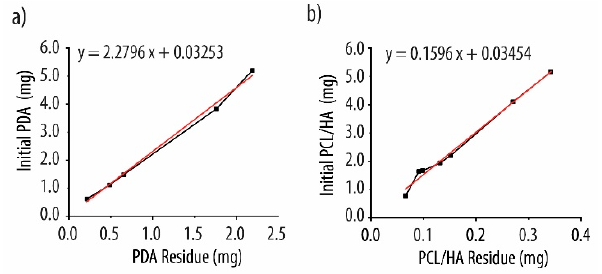
Figure A1. Plots of different initial weights of samples against the residual weights at 800 °C for both PDA ( a ) and PCL/HA scaffolds ( b ).